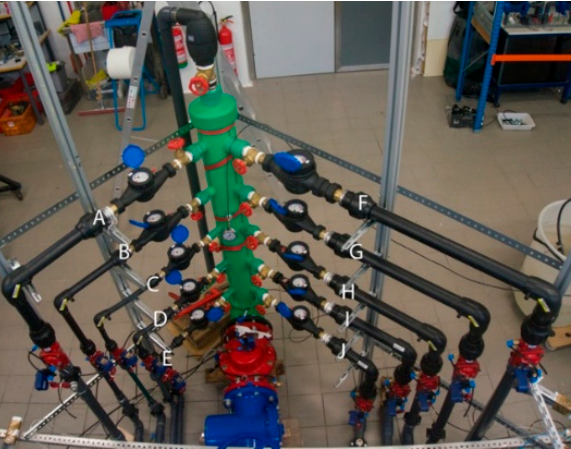
Figure 12. Multioutlet hydrant 12 (H2-5/Type3-10/DNB 150-QNB 51-DNP 20 x3 25 x1 30 x5 40 x1/PN10). Specific outlet diameters A: DNP 30; B: DNP 30; C: DNP 20; D: DNP 20; E: DNP 20; F: DNP 40; G: DNP 30; H: DNP 30; I: DNP 30; J: DNP 25.